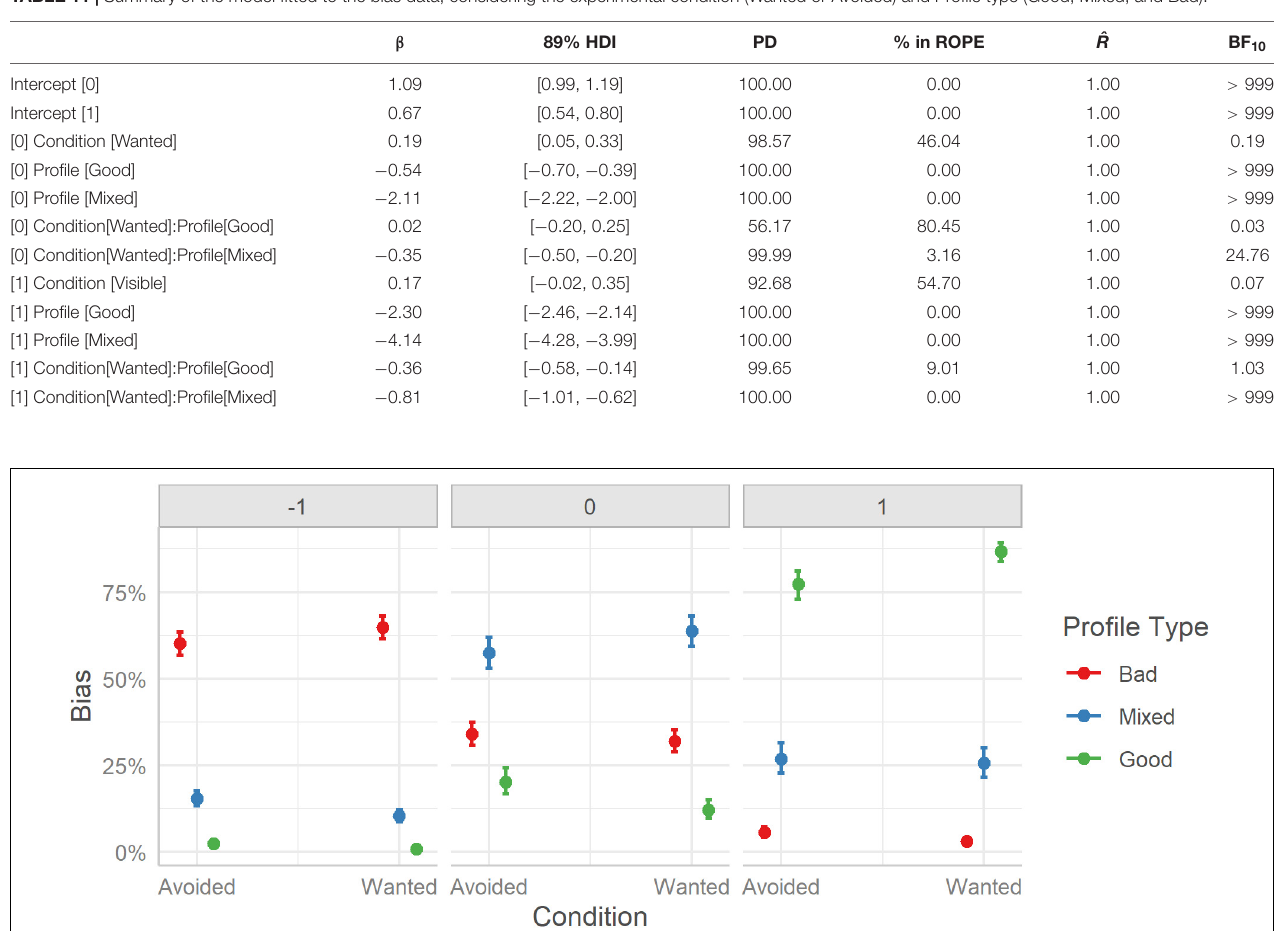
FIGURE 11 | User response bias to rating the profiles between the two experimental conditions (Avoided and Wanted) split over the three Profile conditions (Bad, Mixed, and Good). Error bars indicate 95% credible intervals.